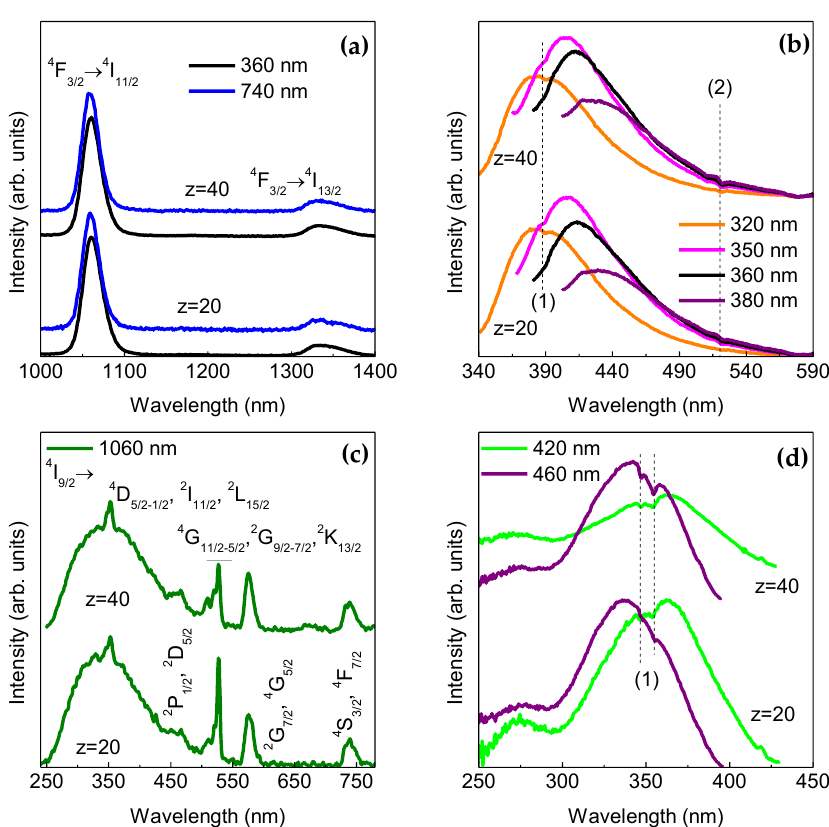
Figure 7. Room temperature ( a ) NIR and (b) UV/visible emission spectra and ( c , d ) excitation spectra of CG 50 Nd z , z = 20 and 40. The ( a , b ) excitation and ( c , d ) monitoring wavelengths are indicated in the figures. (1) and (2) denote the self-absorptions. 4 I 9/2 → 4 D 5/2-1/2 , 2 I 11/2 , 2 L 15/2 , and 4 I 9/2 → 4 G 11/2-5/2 , 2 G 9/2,7/2 , 2 K 13/2 , respectively.